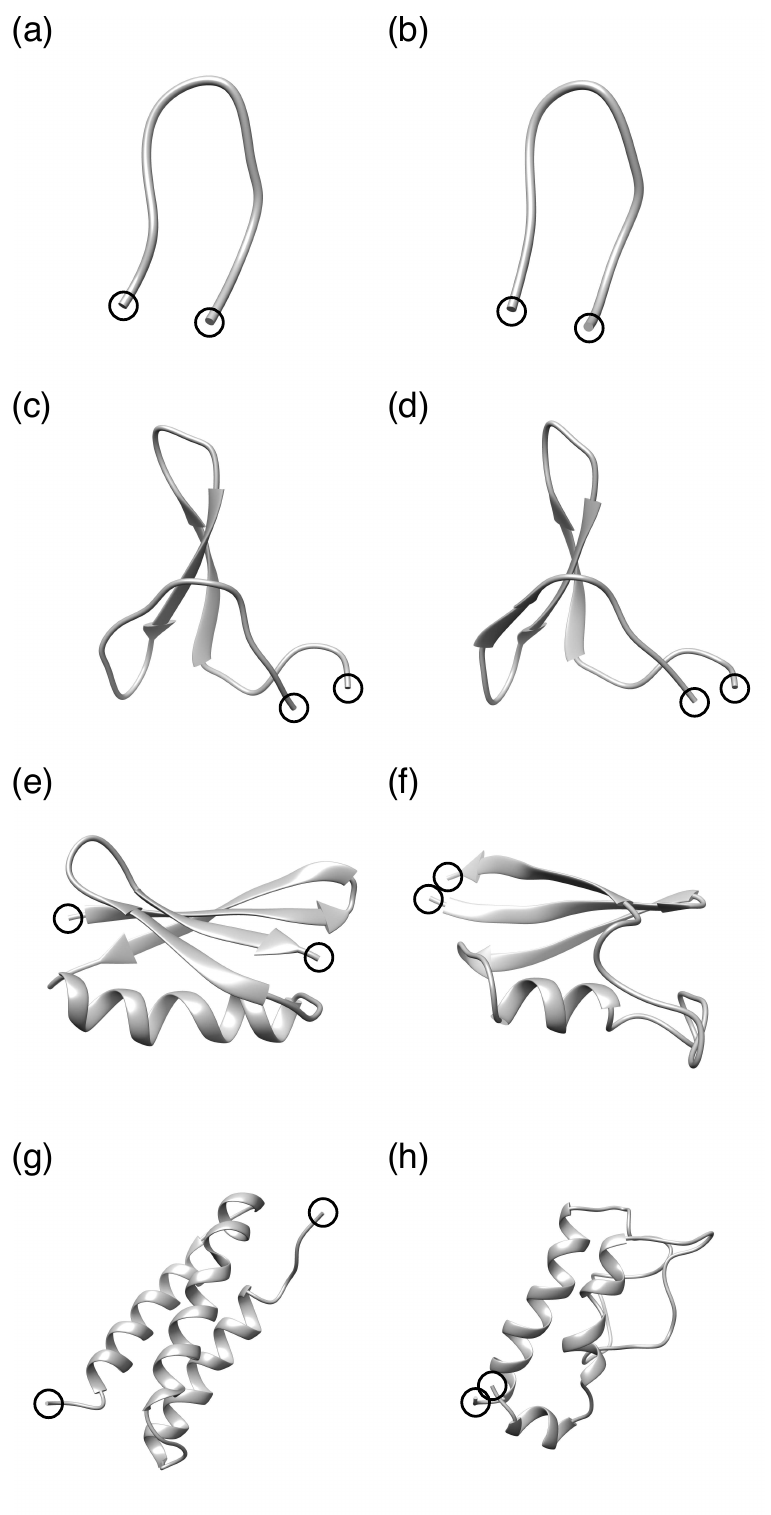
Figure 2. Backbone structures with the lowest total energy and the shortest end-to-end distance for ( a , b ) CLN025, ( c , d ) mGTT, ( e , f ) mNuG2, and ( g , h ) m α 3D. Circles indicate the terminal portions of the protein. Chimera [39] was used to generate the